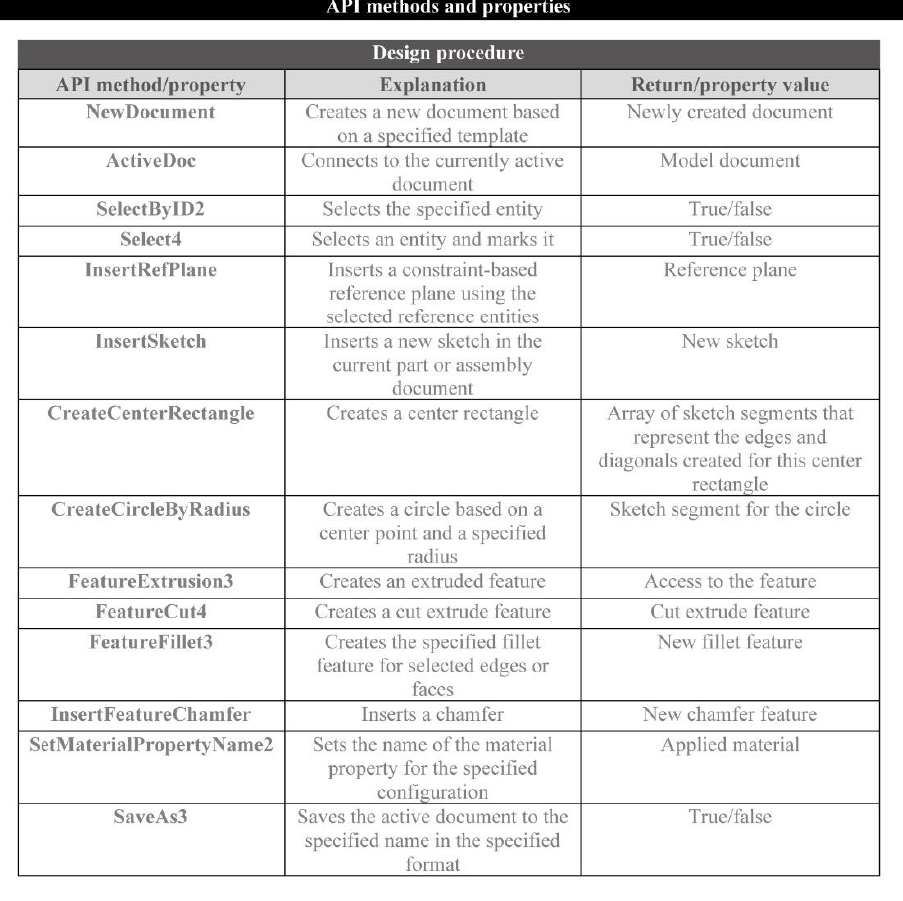
Figure 5. API methods and properties used for the assembly procedure.